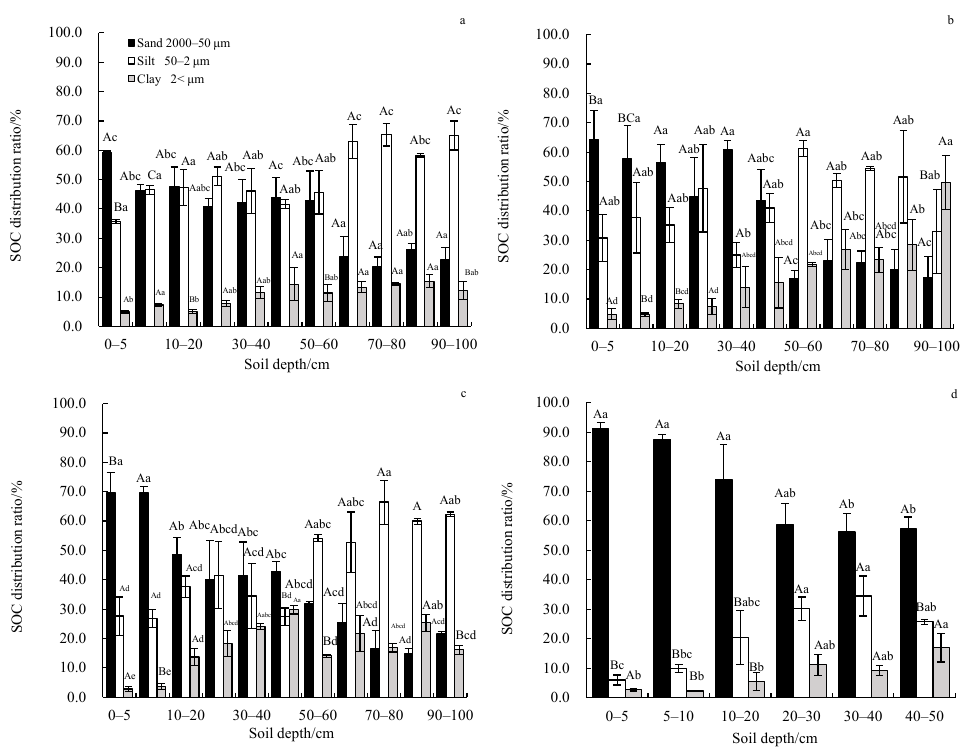
Figure 6. SOC distribution ratio of woodlands in different restoration years. (( a – d ) in the figure represent restoration 5a, 8a, 15a, and 20a, respectively), Notes: The lowercase letters in the figures represent significant differences in the same component at different depths ( p < 0.05), and the uppercase letters indicate significant differences in the same component at the same depth in different restoration years ( p < 0.05).